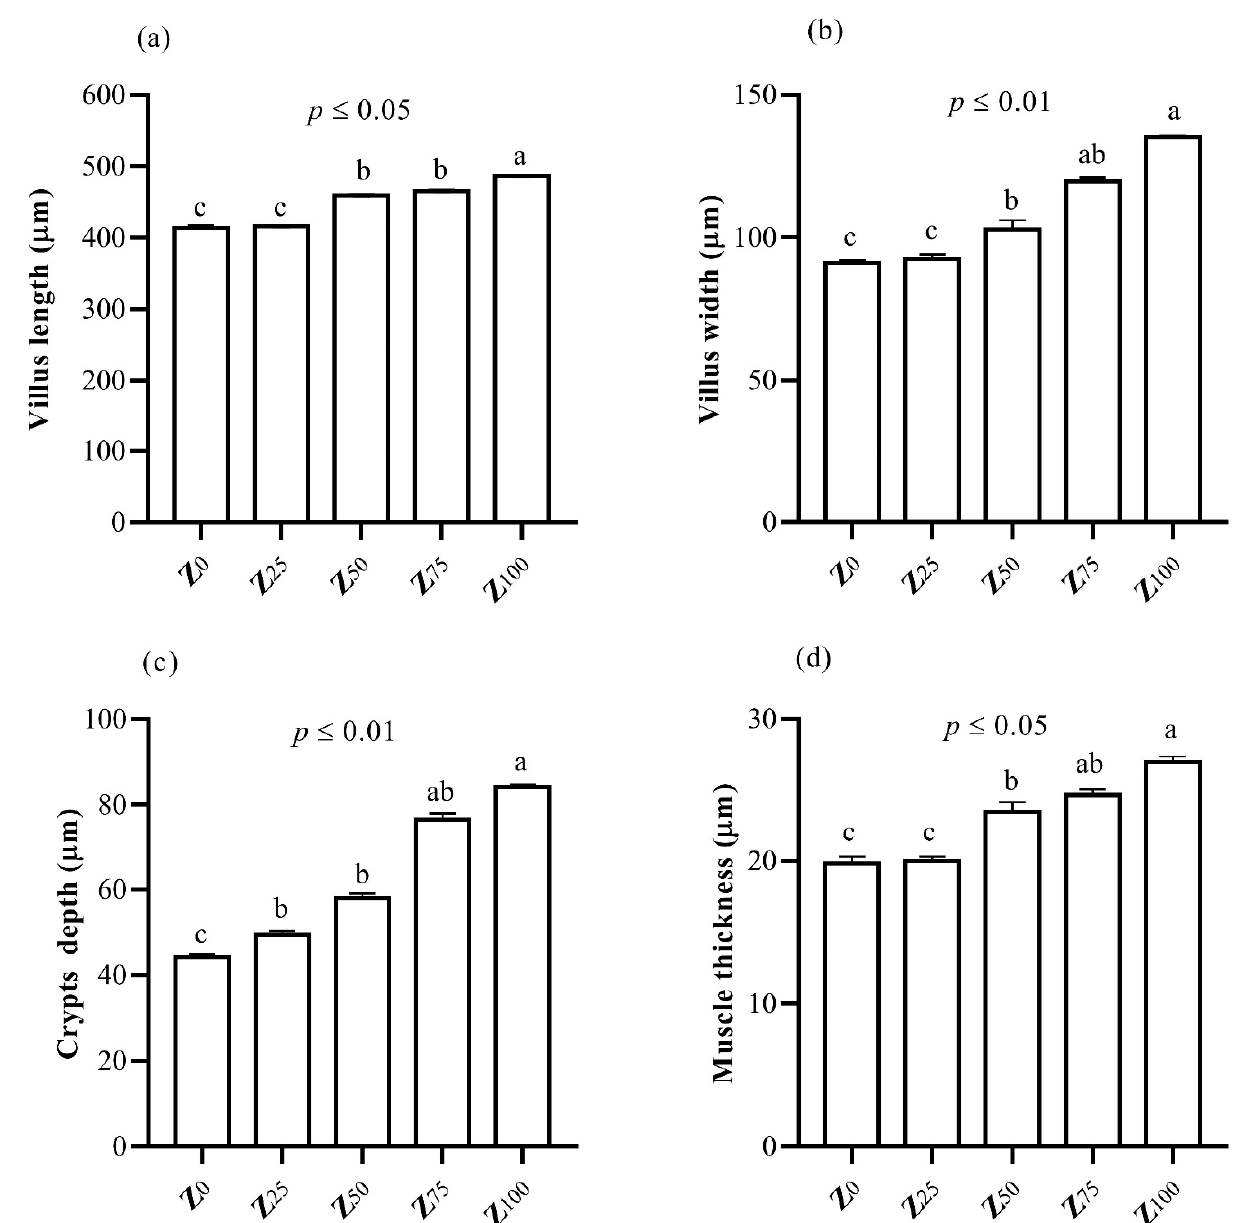
Figure 3. Intestine histo-morphometrics indexes of grey mullet, Mugil cephalus , fed experimental diets for 60 days: ( a ) villus length; ( b ) villus width; ( c ) crypts length; ( d ) muscle thickness. Z 0 = diet without zooplankton biomass meal (ZBM) inclusion; Z 25 , Z 50 , Z 75 , and Z 100 have 25, 50, 75, and 100% fishmeal replaced with ZBM, respectively. The columns bearing different superscripts indicate significant differences as determined by Tukey’s test ( p ≤ 0.05).